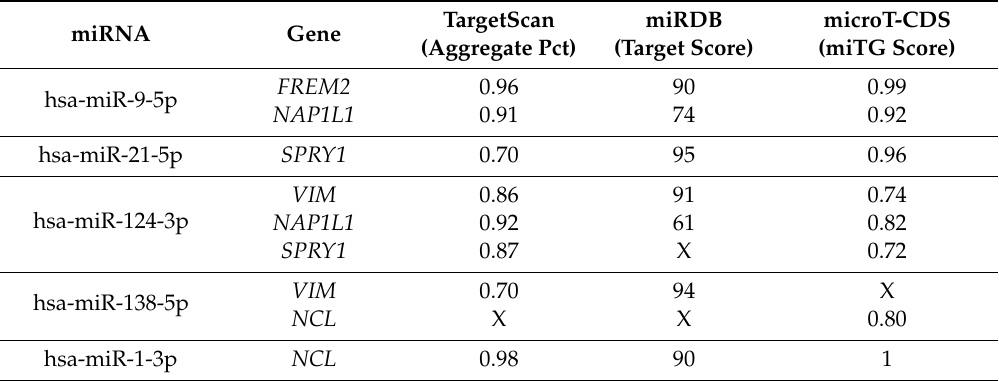
Table 1. Candidate miRNAs with the corresponding target mRNA determined by the TargetScan, miRDB, and microT-CDS datasets. miRNA Gene